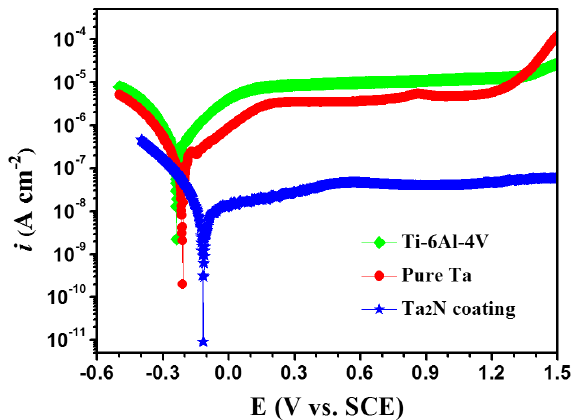
Figure 8. Potentiodynamic polarization curves of uncoated Ti-6Al-4V, commercially pure Ta and the Ta 2 N coating in Ringer’s physiological solution at 37 °C. Table 1. Electrochemical parameters extracted from potentiodynamic curves of investigated specimens in Ringer’s physiological solution at 37 °C.